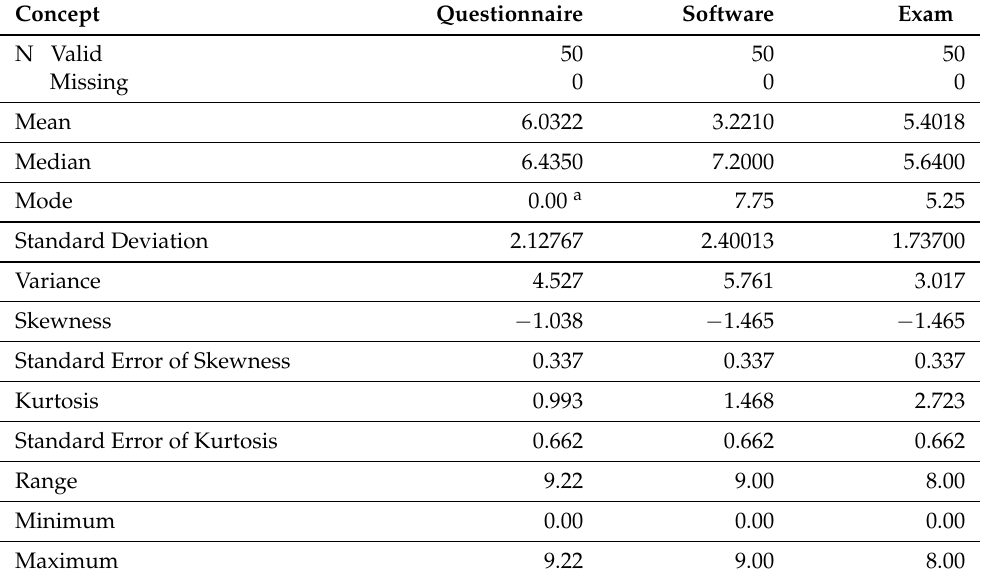
Table 2. Descriptive statistics for the academic year